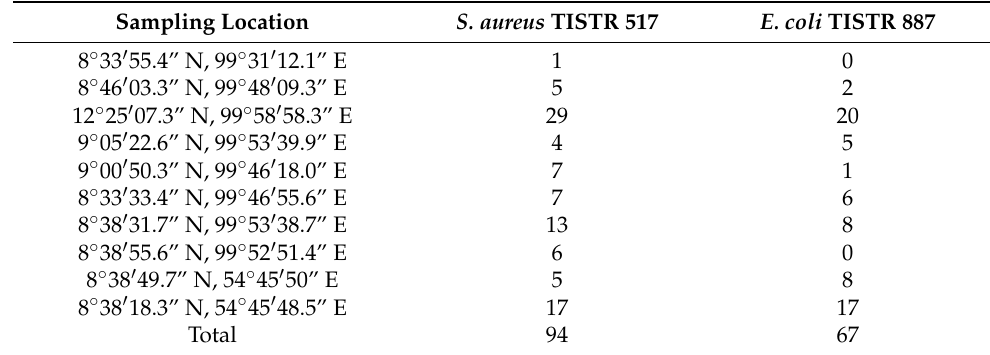
Table 1. Sampling locations and the number of soil isolates that exhibited antibacterial activity from the cross-streak